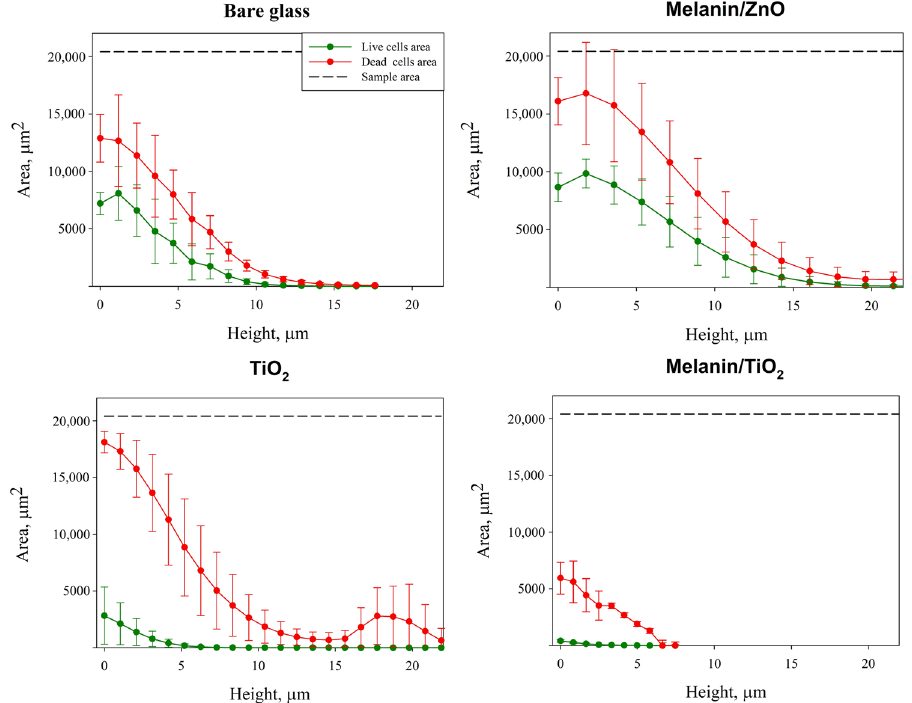
Figure 6. Area occupied in each layer of the Z-scan acquisition by dead cells (in red) and live cells (in green). The grey line represents the total surface area. The height represents biofilm thickness starting from the bottom surface layer to the last biofilm layer detected for each sample. Area is evaluated by processing CSLM stack images of biofilms cultivated under different coatings: bare glass, melanin/ZnO, TiO 2 , melanin/TiO 2 . Average values ± standard deviation calculated from at least triplicate independent experiments are shown.